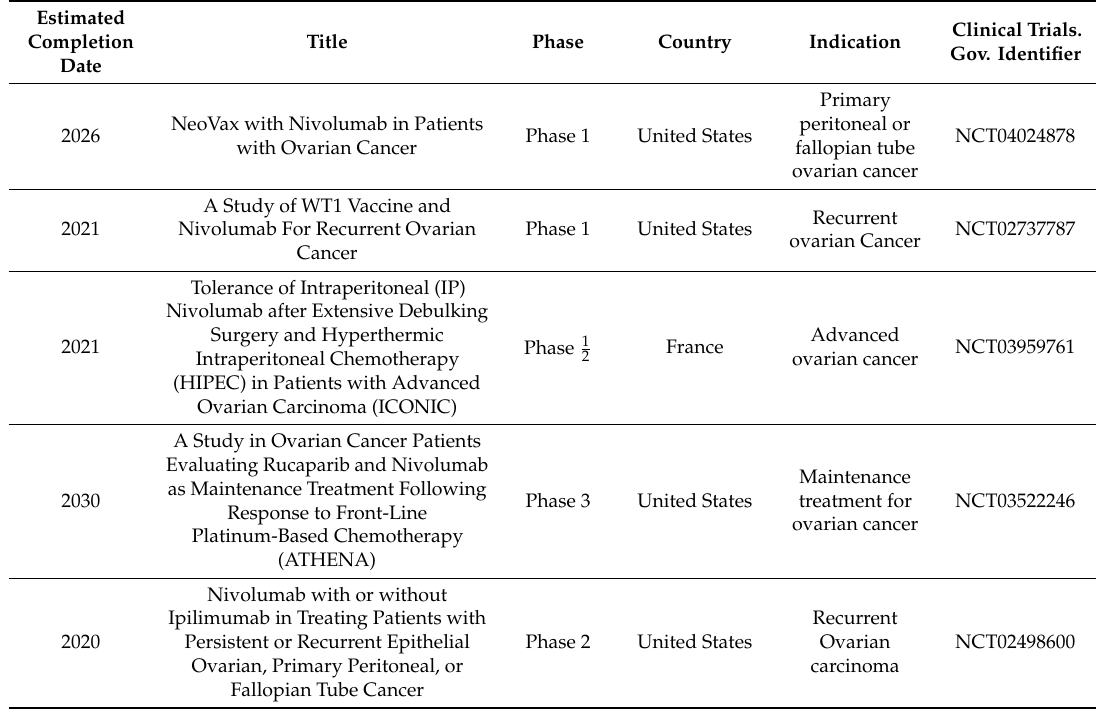
Table 3. Ongoing trials (up to February 2020) of nivolumab in ovarian